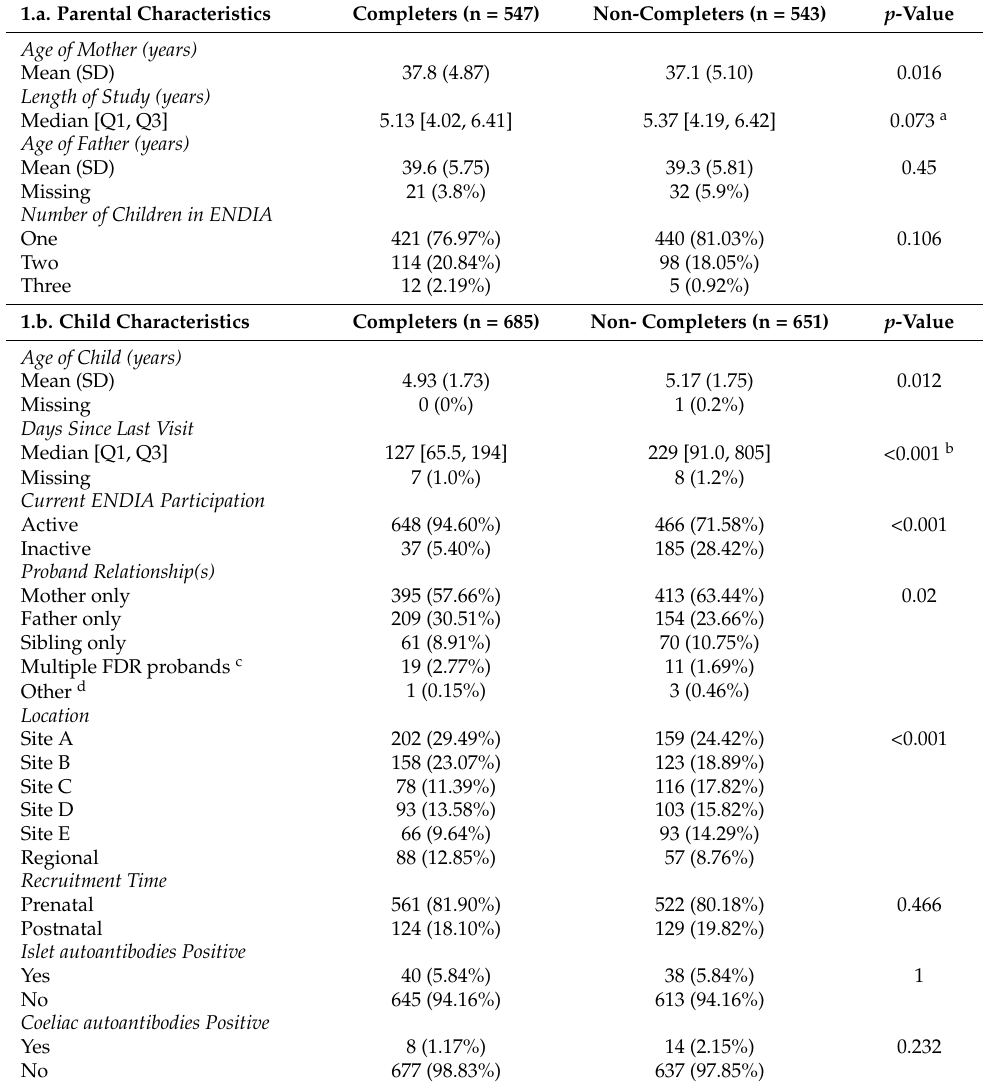
Table 1. Characteristics of ENDIA families (1.a: all parents, 1.b: all children) who did and did not complete the